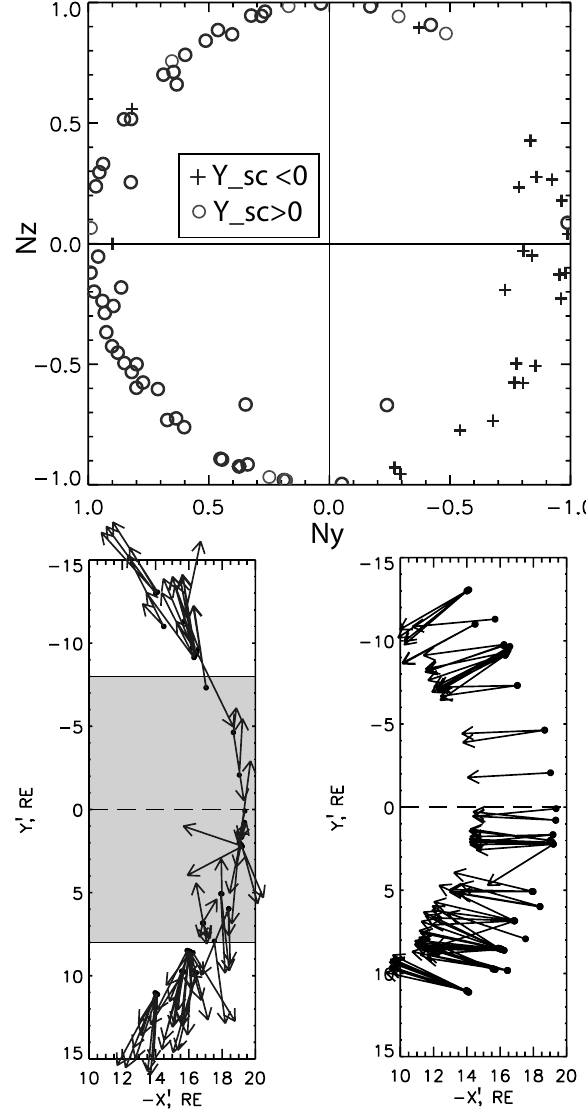
Fig. 5. Distribution of Y and Z components of the normal veloc- ity V n resulting from timing analysis of current sheet crossings in the post-midnight (crosses) and the pre-midnight (circles) sectors (upper panel) and projections of V n onto the X 0 − Y 0 (left-hand bot- tom panel), the shadowed box indicated the area omitted by Sergeev et al. (2004); Right-hand bottom panel: Projections of maximum variance MVA eigenvectors onto the X 0 − Y 0